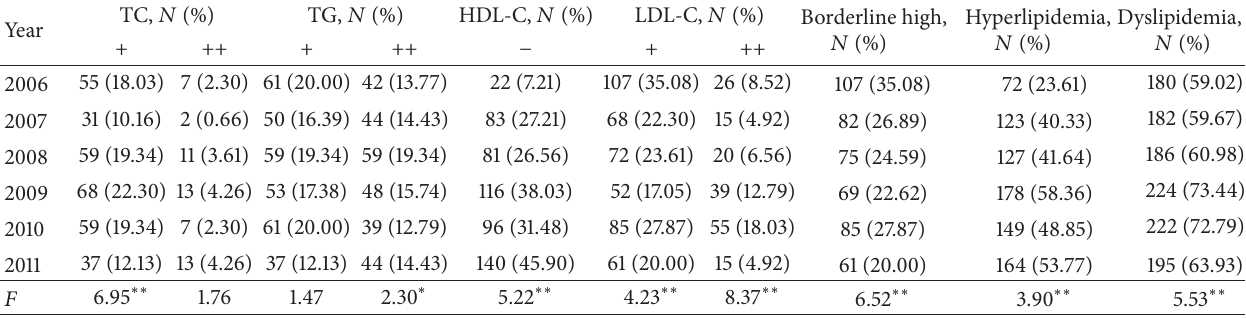
Table 4: Lipid index classifications and prevalence of lipid conditions of civil aviators in China by year 2006–2011 ( 𝑁 = 305 ).